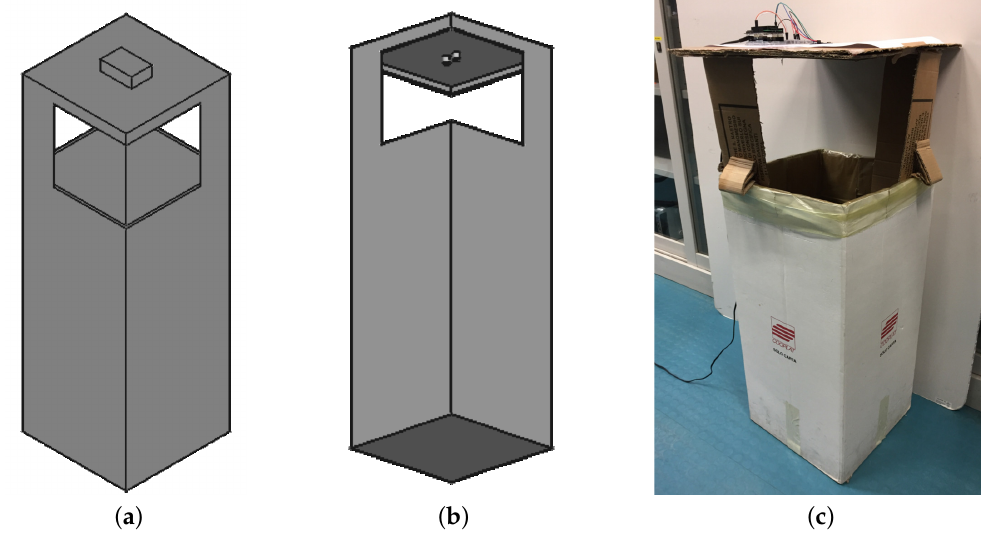
Figure 7. Experimental setup for the validation of the sensor. 3D model of the sensing structure: ( a ) axonometric view from above; ( b ) axonometric view from below; ( c ) final realization.